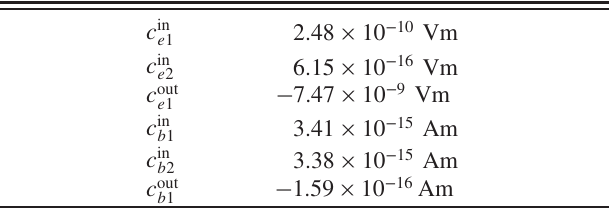
for an elementary point charge at a vacuum-Cr 2 O 3 interface. The corresponding parameters are in units of ampere-meters (Am) for the magnetic potentials and in units of volt-meters (Vm) for the electric potential